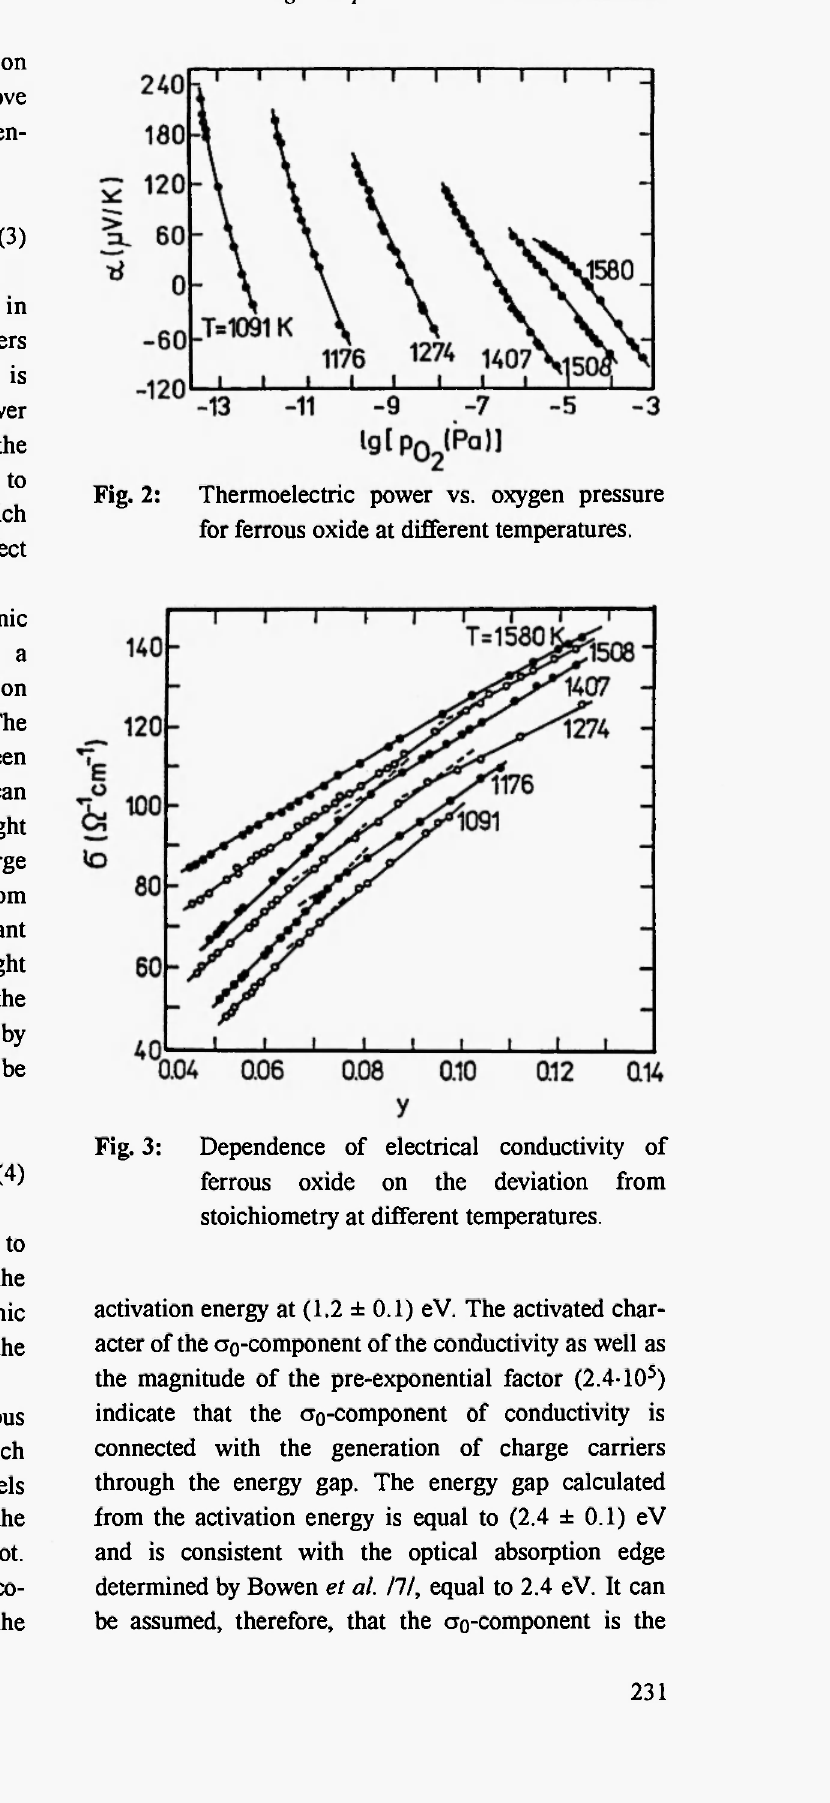
Fig. 2: Thermoelectric power vs. oxygen pressure for ferrous oxide at different temperatures.